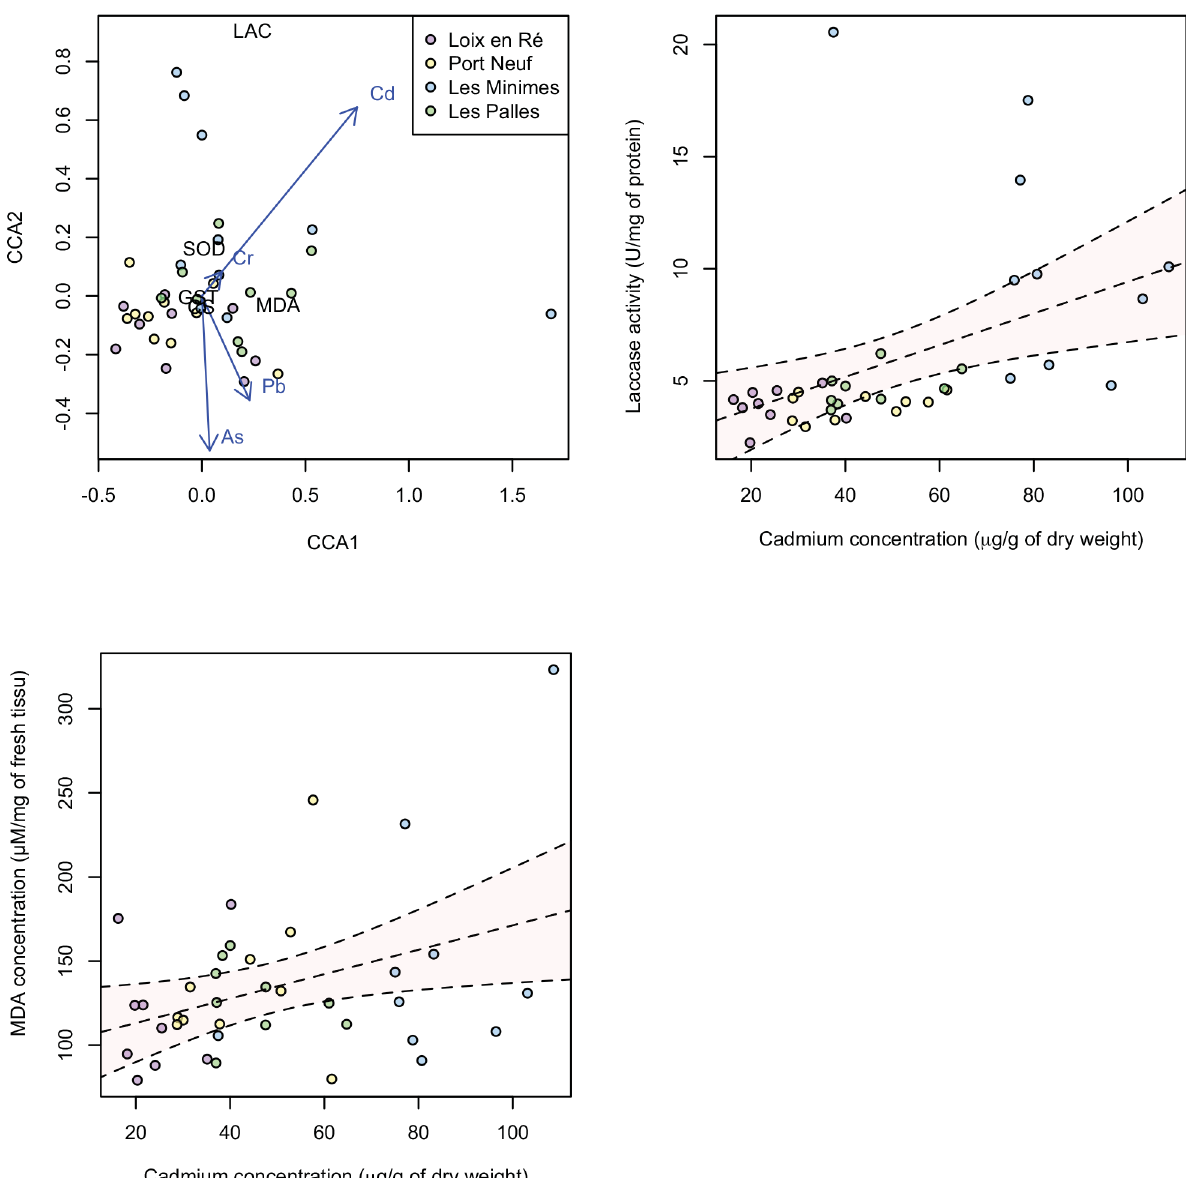
Fig 5. Canonical Correspondance Analysis (CCA) ordination plot of biomarker responses for individuals collected in March at four sampling sites (represented by different colors), and the trace metals explaining the variation in the individual x biomarker matrix (blue arrows). Biomarker values were scaled to 1/3 as to fit on the plot. The first two axes explain 44% of the variance in the data (40% and 4%, respectively). CS: Citrate synthase activity, MDA: MDA contents, SOD: SOD activity, GST: GST activity, LAC: Laccase